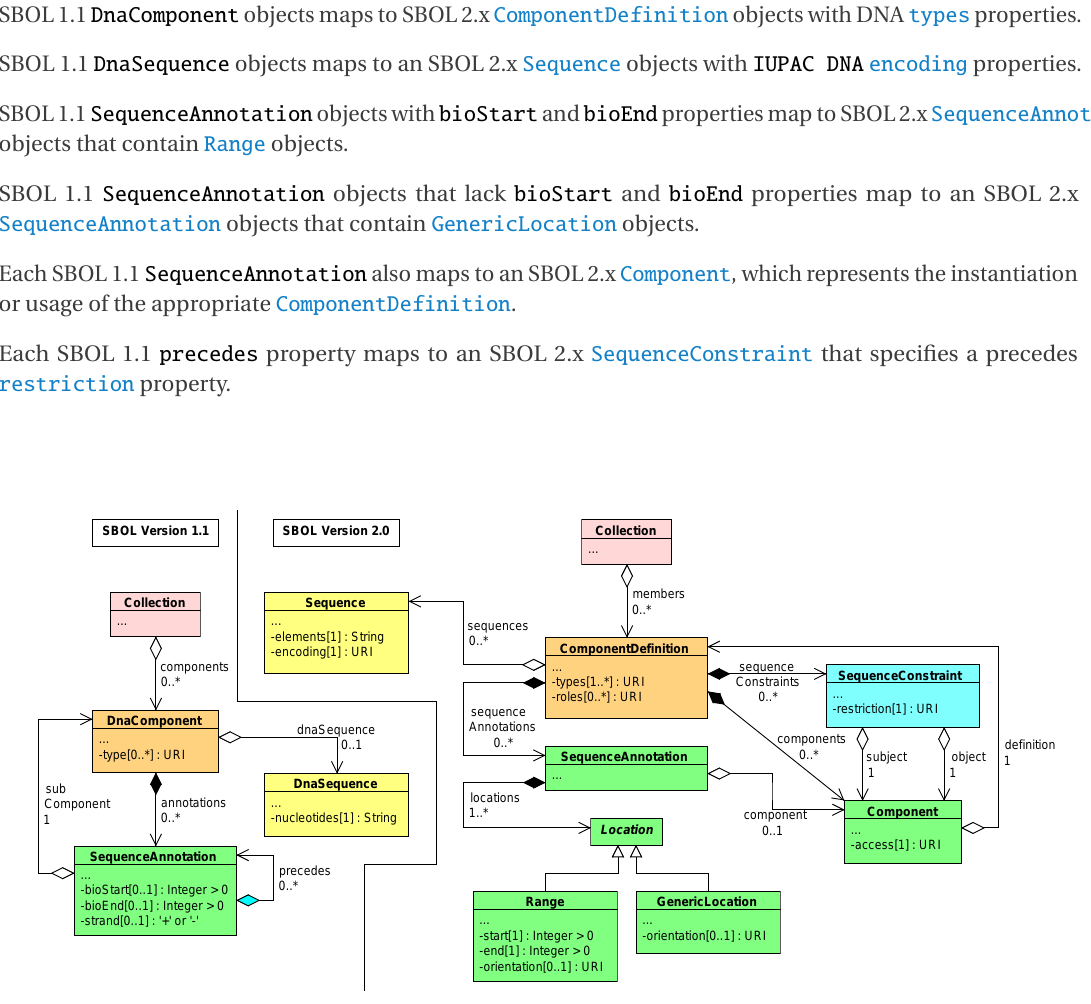
Section 8 Mapping Between SBOL 1.1 and SBOL